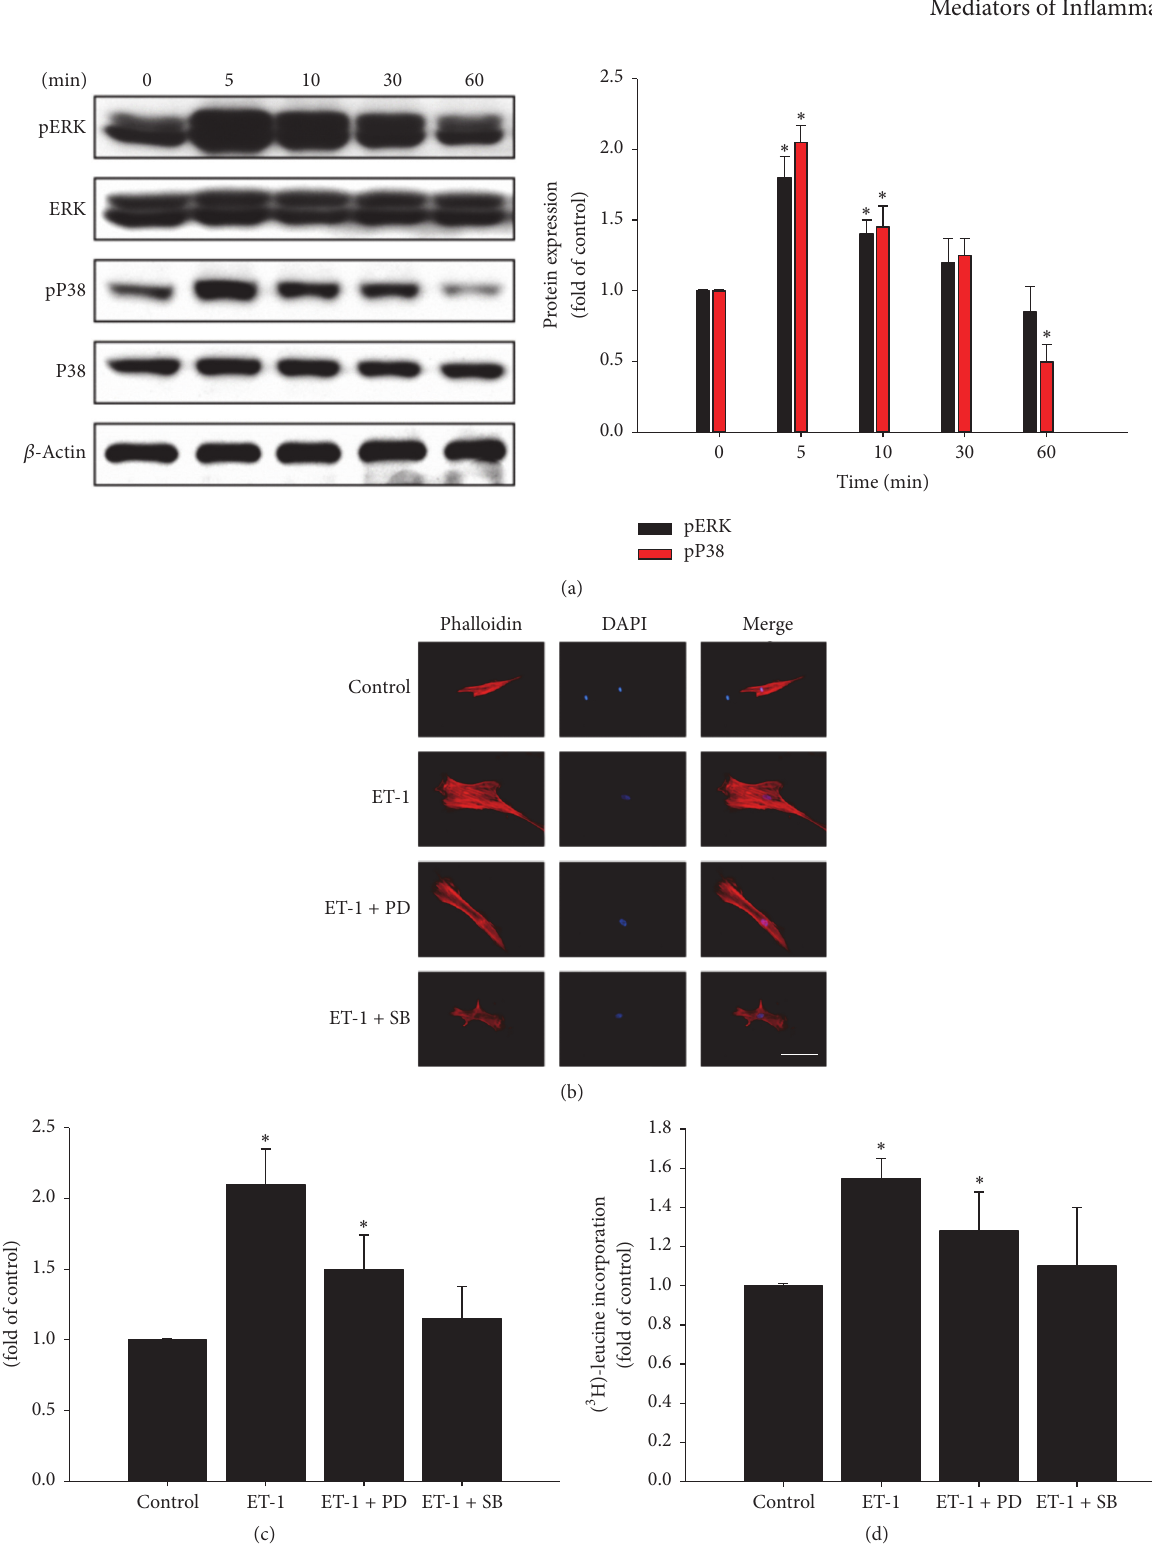
Figure 3: Signaling pathways in ET-1-induced cell hypertrophy and adiponectin expression. In human cardiomyocyte cells, phosphorylation ofERKandp38wasdeterminedbyimmunoblotassay(a).Assayswereperformedintriplicate.TheroleofERKandp38andET-1inmyocardial cell size was determined in cells pretreated with PD98059 (ERK inhibitor) or SB203580 (p38 inhibitor) for 1h, followed by stimulation with or without ET-1 (50 nM) for 48 h. Cells were fixed and stained with rhodamine-phalloidin (red) and DAPI (blue) followed by cell surface area quantitation (scale bar, 50 𝜇 m) (b). Data are expressed as mean ± SEM of values from three independent experiments (c). 3 H-leucine incorporation was determined as a measure of relative protein synthesis (d). ∗ 𝑃 < 0.05 , compared with 0 min group (a) or untreated control group